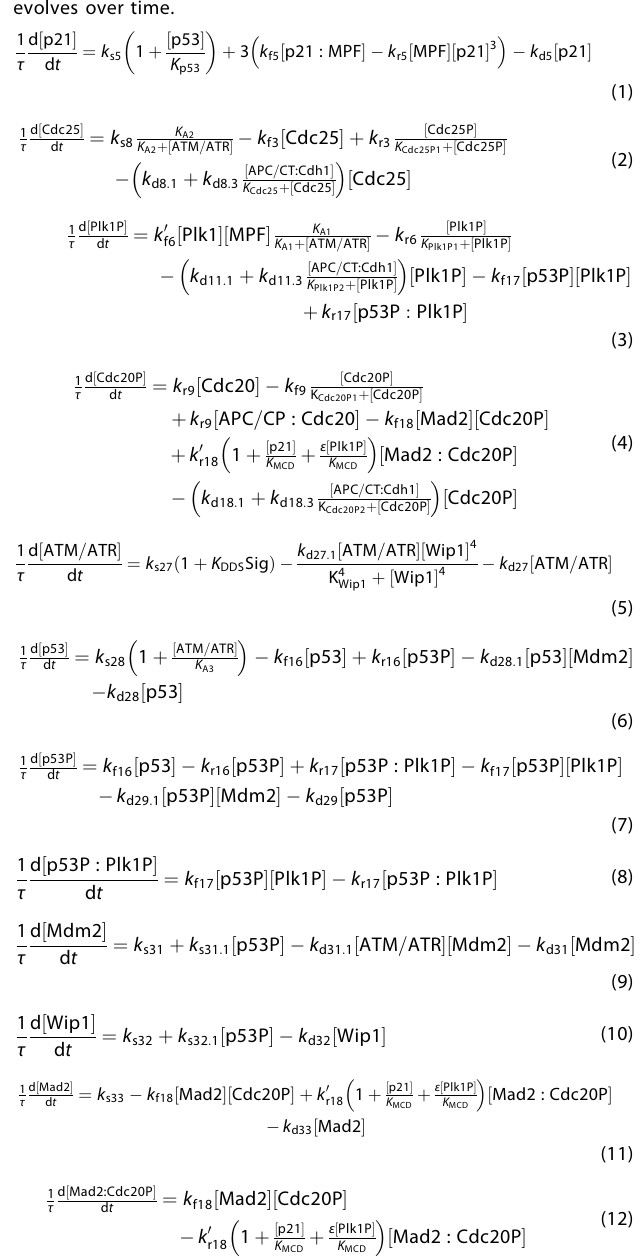
Parameter sensitivity